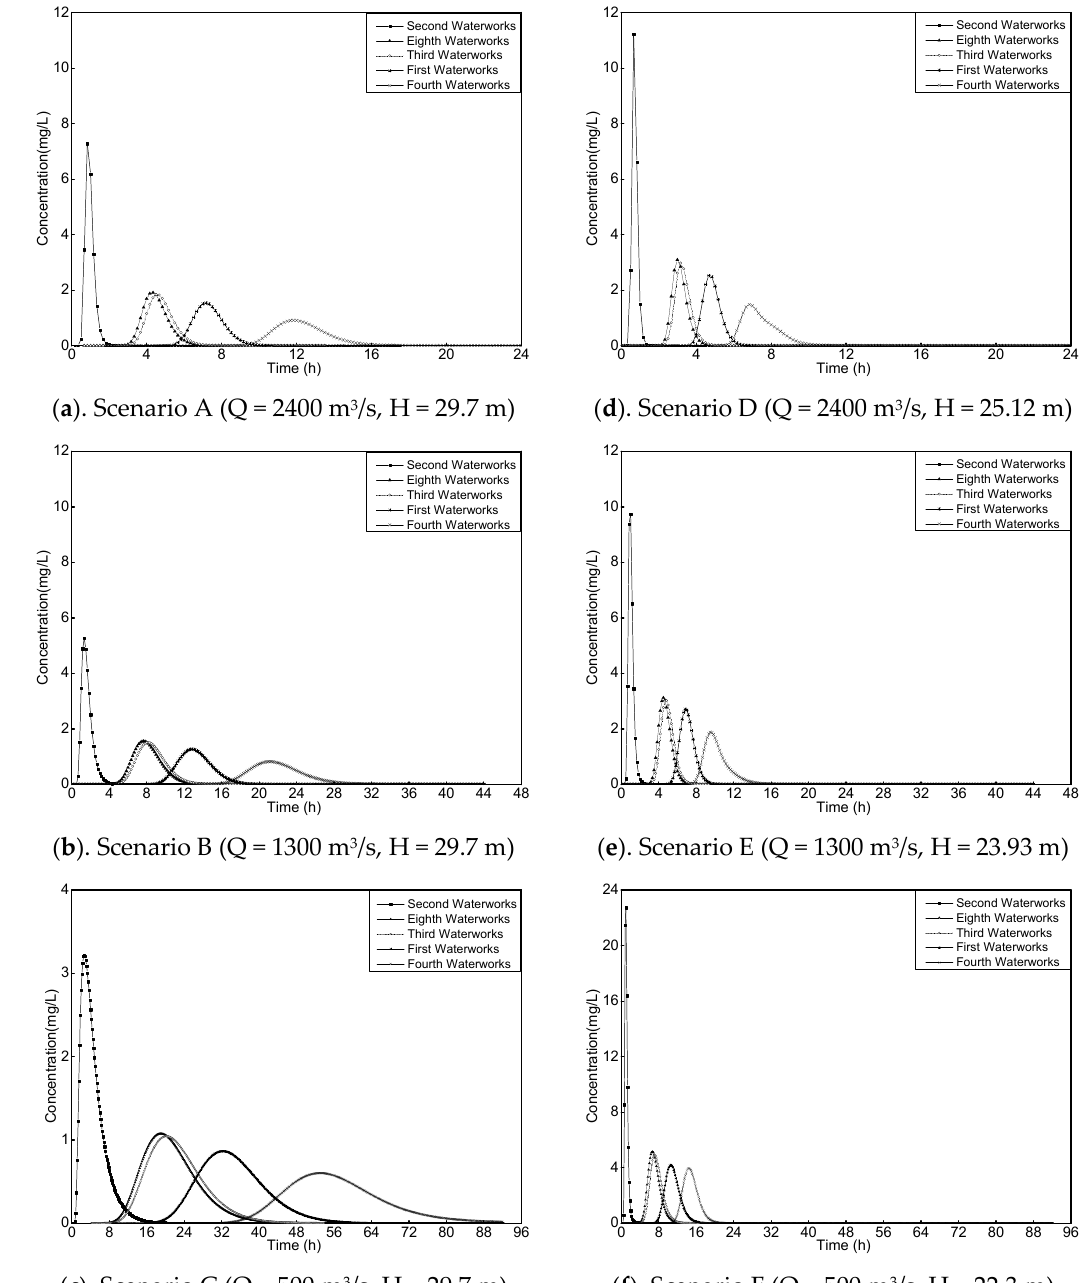
Figure 6. Pollutant concentration at different waterworks intakes along the reach between Heishipu Bridge and CCCP.